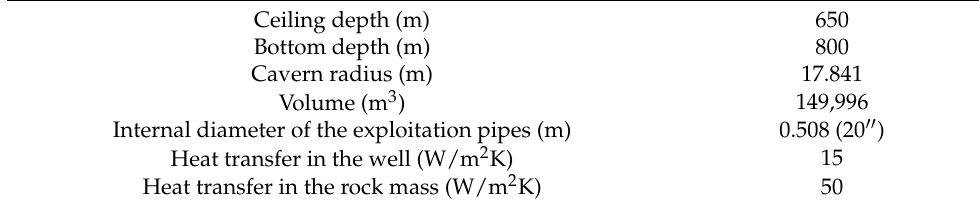
Table 5. Foundation depth and geometrical parameters of the cavern adopted for